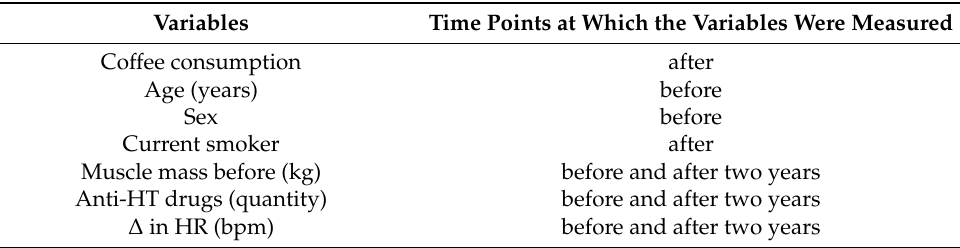
Table A2. Time points at which the variables included in linear mixed model were measured. Variables Time Points at Which the Variables Were Measured Coffee consumption after Age (years) before Sex before Current smoker after Muscle mass before (kg) before and after two years Anti-HT drugs (quantity) before and after two years ∆ in HR (bpm) before and after two